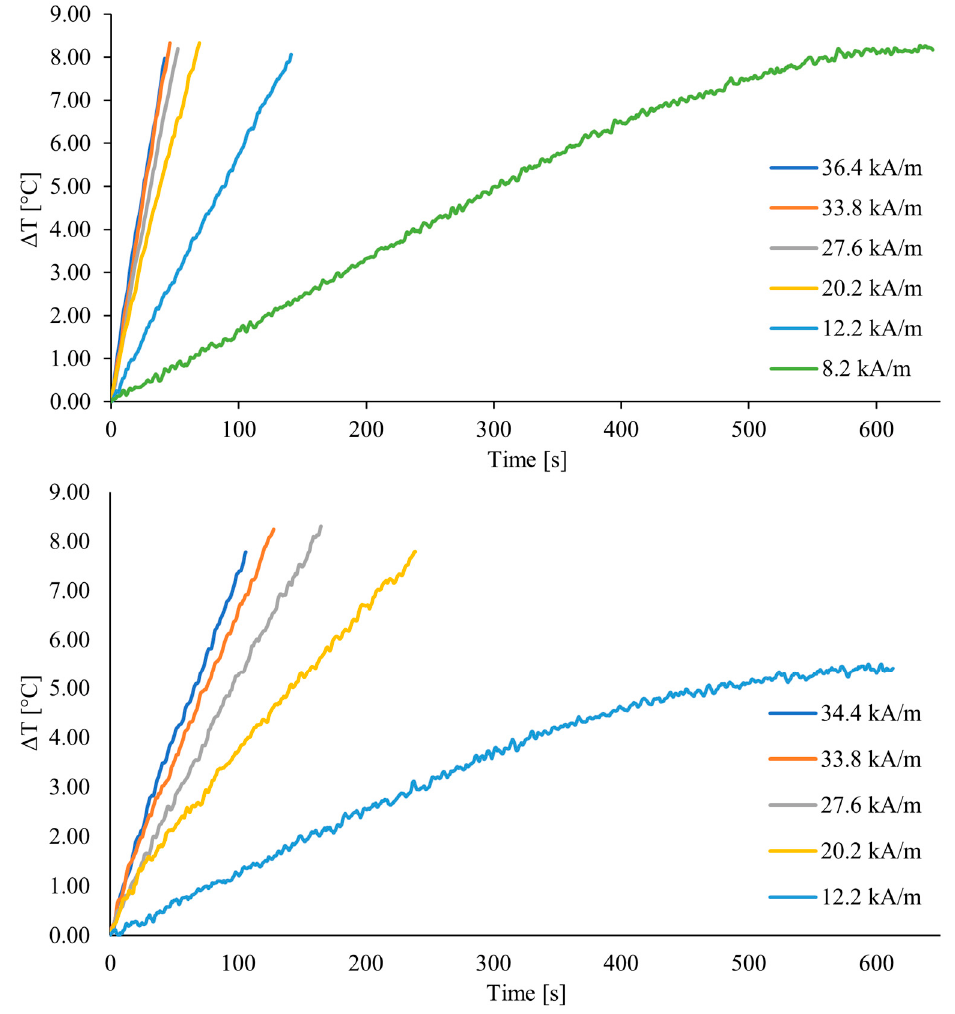
Figure 10. Heating curves for MION suspensions at 5 mg/mL (top) and 2 mg/mL (bottom) (sample S9).